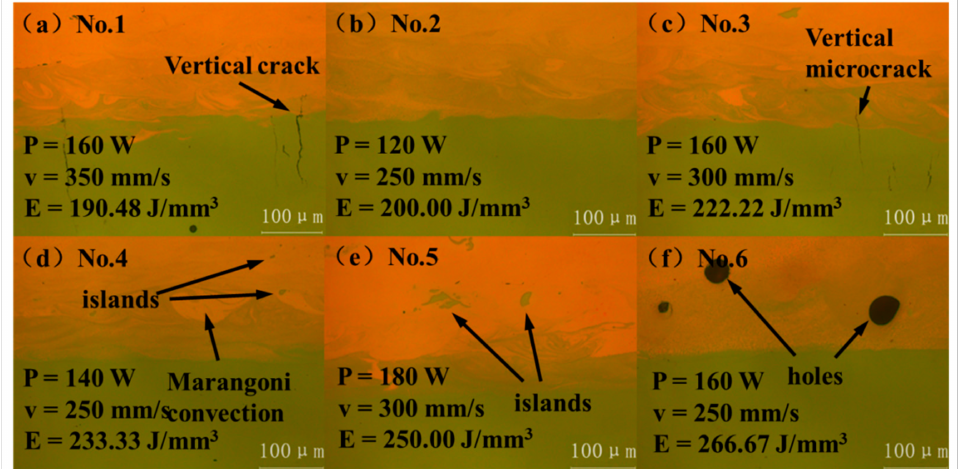
Figure 4. Optical micrographs of interfaces: Sample ( a ) No.1; ( b ) No.2; ( c ) No.3; ( d ) No.4; ( e ) No.5; ( f )